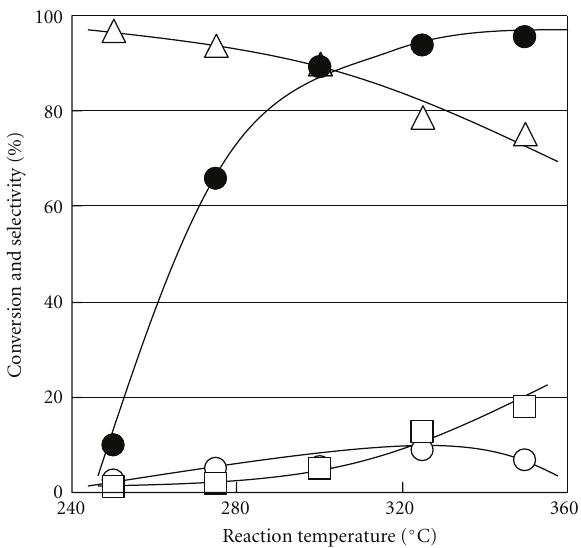
Figure 14: Conversion and product selectivity of hydrocracking of hydrotreated oil over [NiMo/ γ -Al 2 O 3 ]/ ns Al 2 O 3 /H-beta zeolite cat- alyst depending on reaction temperature. • : Conversion; selectivity: (cid:2) (cid:4) : normal para ffi ns; : isopara ffi ns; (cid:2) : olefins.